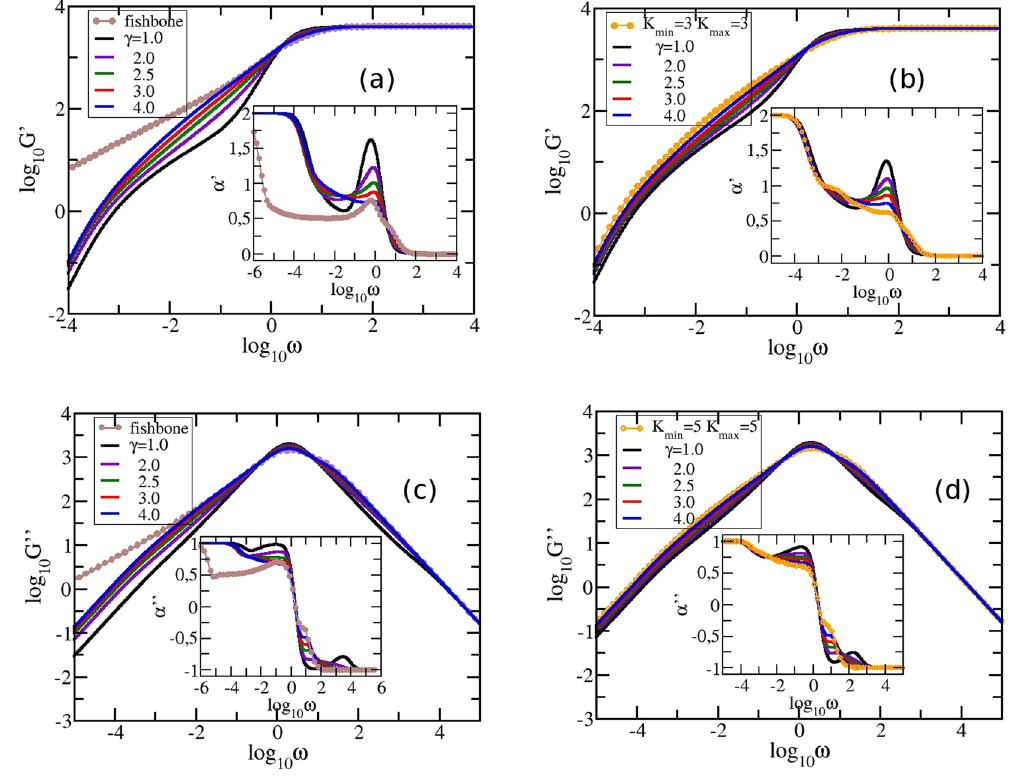
Figure 7. The storage modulus (upper row) and the loss modulus (lower row) for GSFPNs with N = 4000. The parameters’ set ( K min , K max ) is equal to: ( a ) (3, 400), ( b ) (3, 80), ( c ) (5, 3999), and ( d ) (5,